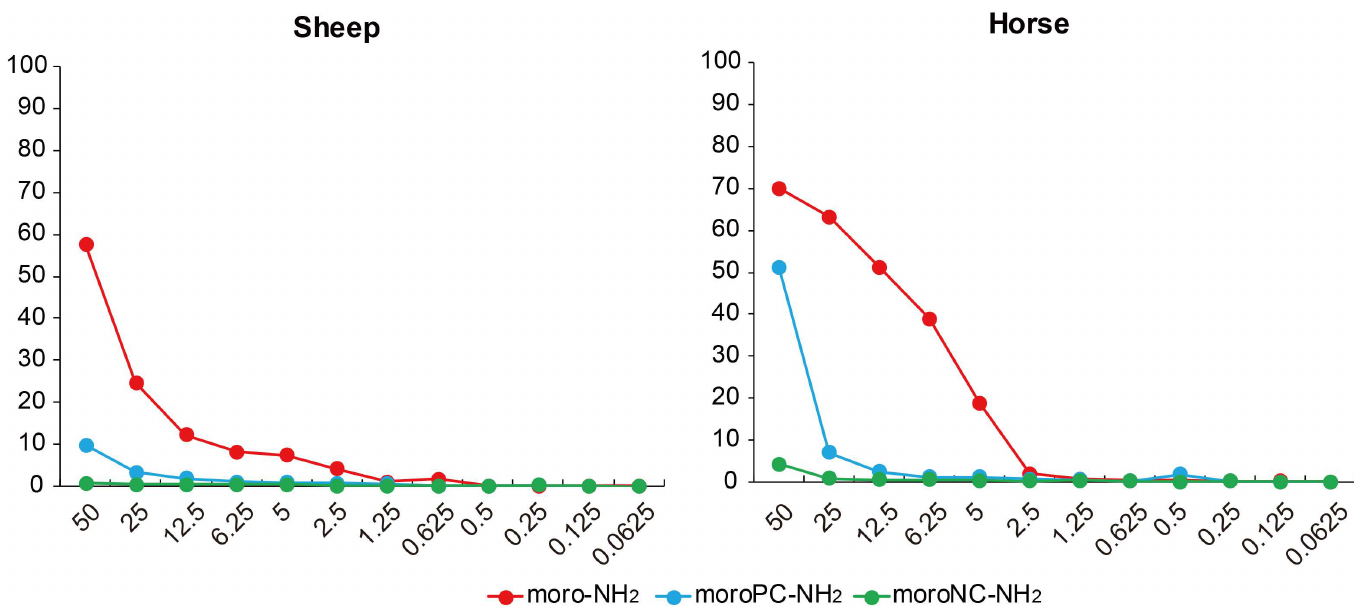
bass. However, we could not find any advantages conferred by this distinctive amino acid sequence. In spite of its low toxicity, moroNC-NH activity, and high salt sensitivity. These characteristics make it difficult to consider mor- oNC-NH for clinical use. 2